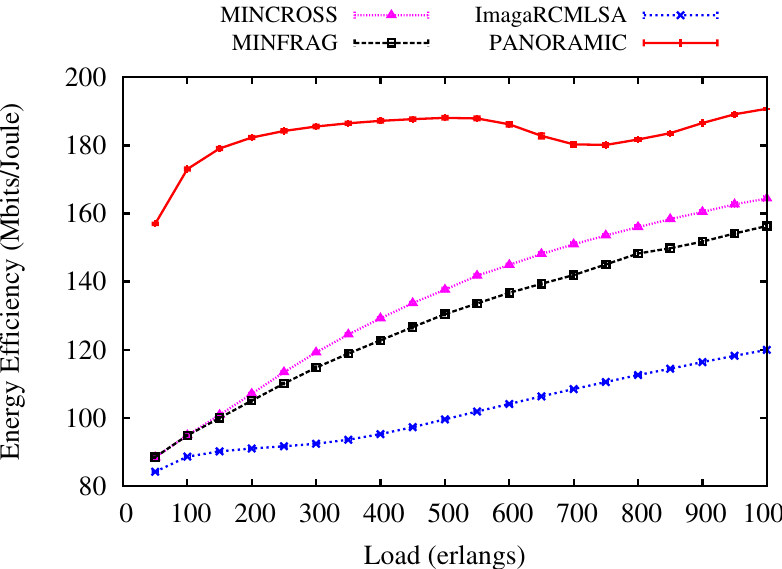
Figure 7. Energy Efficiency for USA